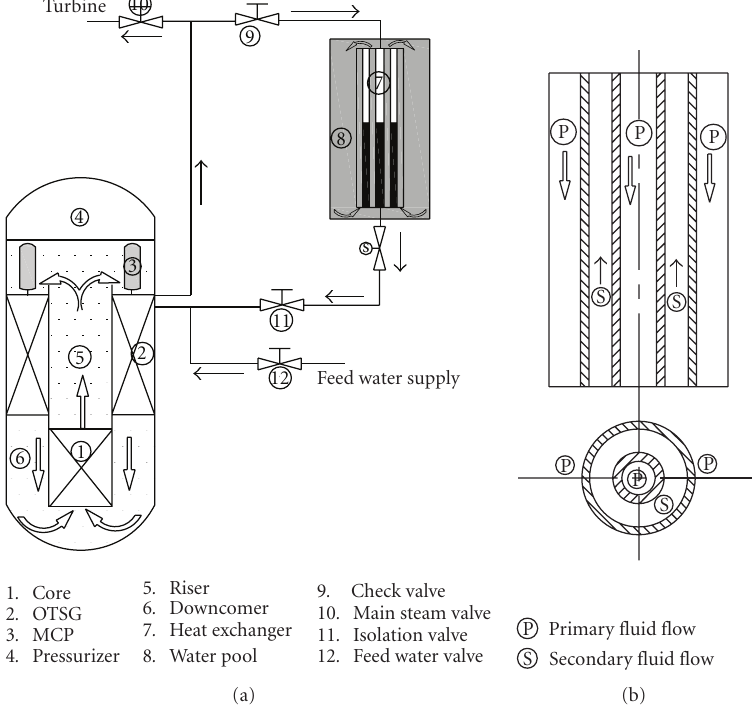
Figure 1: Schematic diagram of the PRHRS and OTSG heat transfer